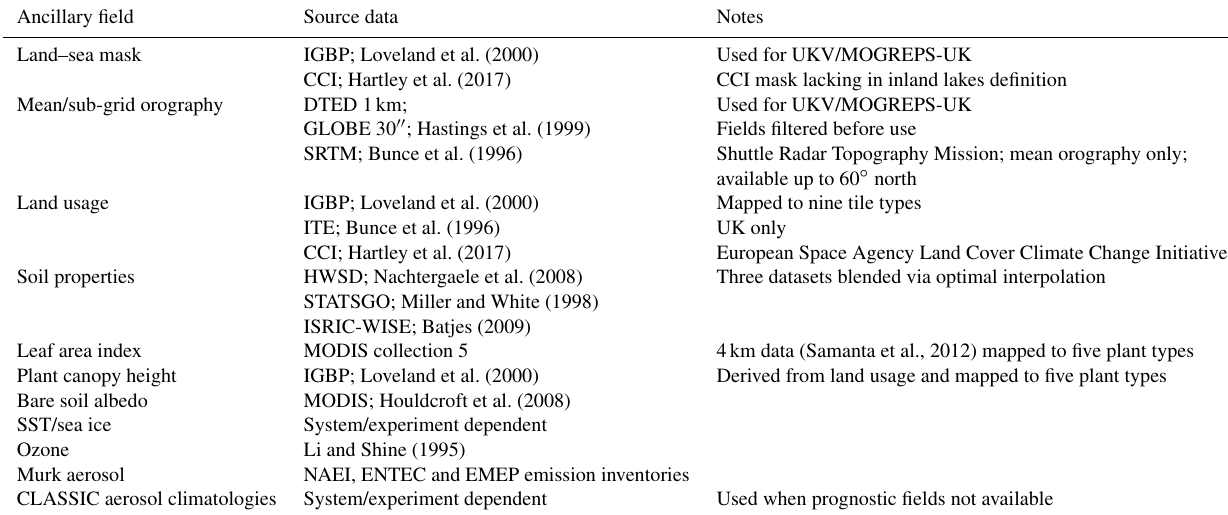
Table A1. Source datasets used to create standard ancillary files used in